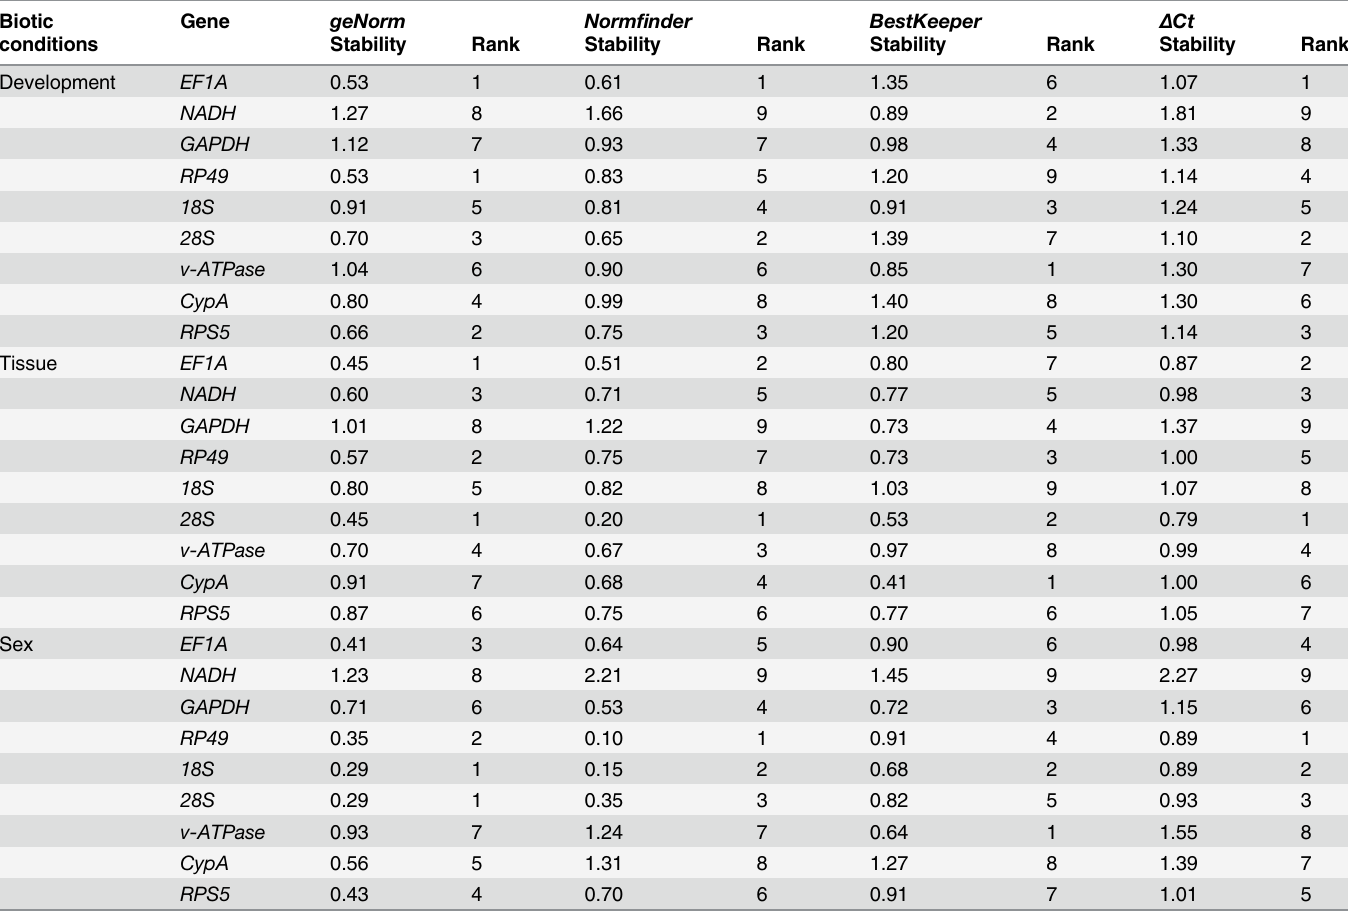
Table 2. Stability of reference gene expression under biotic conditions. Biotic